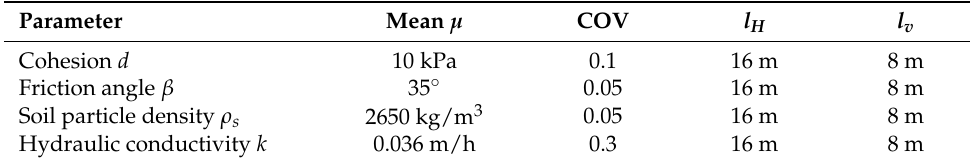
Figure 20. The generation of random fields of cohesion. Table 3. The parameters for the stochastic analysis.